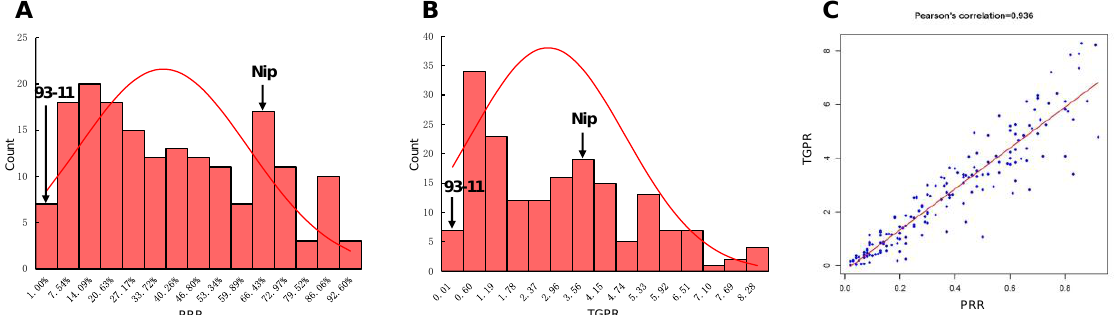
Figure 2. Statistical analysis of PRR and TGPR. ( A ) Frequency distribution diagram of PRR, with arrows indicating the level of the parents 93-11 and Nip. ( B ) Frequency distribution diagram of TGPR in the population, with arrows representing the level of the parents 93-11 and Nip. ( C ) Correlation coefficients between PRR and TGPR.